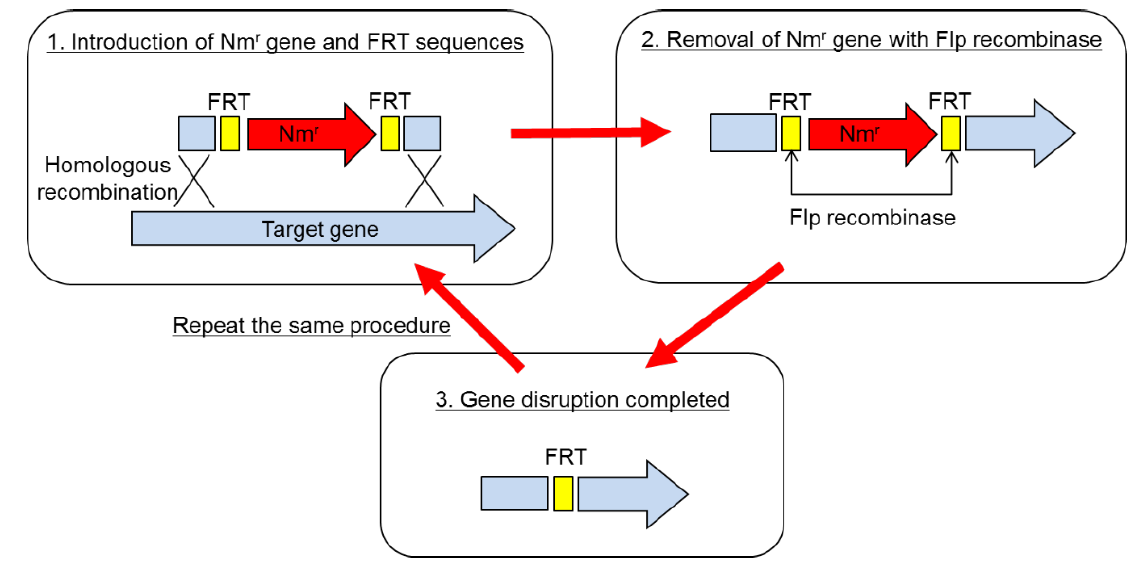
Figure 1. Gene disruption procedure for Brevibacillus choshinensis